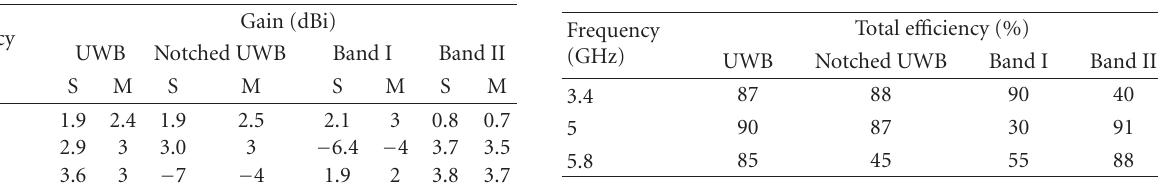
Figure 7: Simulated input impedance curves for the UWB antenna when the antenna is configured to operate in Band I. Table 2: Simulated (S) and measured (M) realized gain. Table 3: Measured total e ffi